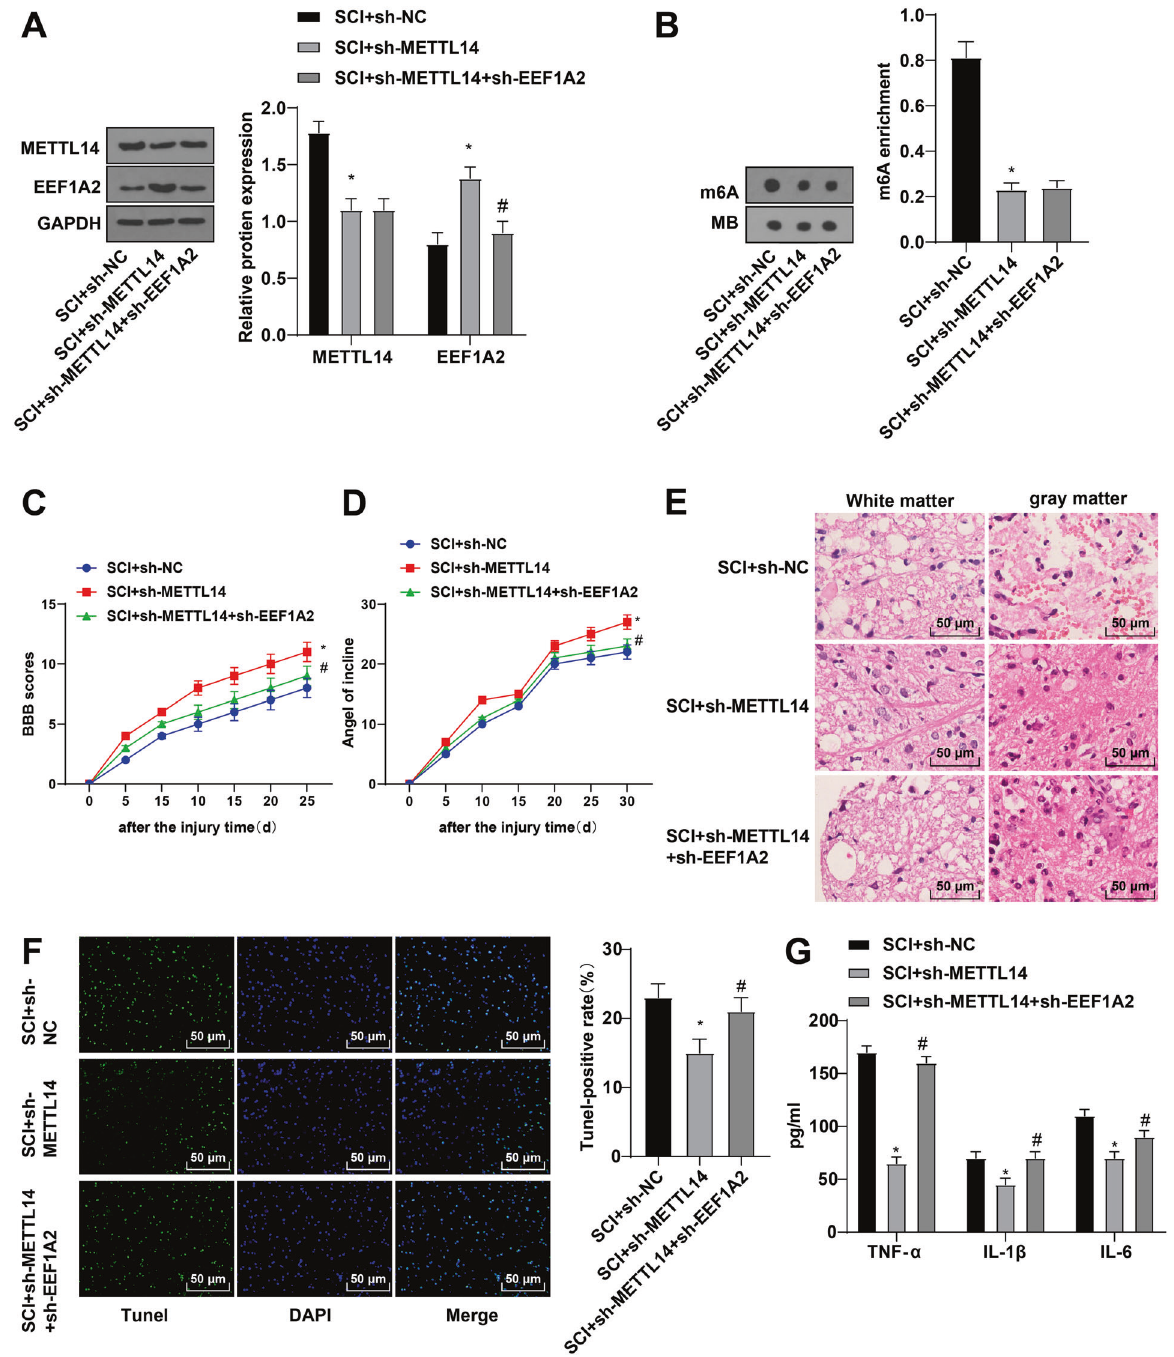
Fig. 6 Mettl14 modulated SCI by mediating EEF1A2 expression. A expressions of Mettl14, EEF1A2 proteins in spinal cord tissues detected by Western blot; ( B ) total m6A level detected by Dot blot assay; ( C ) locomotor ability detected by BBB locomotor rating scale; ( D ) neuronal function detected by inclined plane test; ( E ) pathological conditions of spinal cord assessed by HE staining; ( F ) apoptosis of spinal cord tissues detected by TUNEL staining; ( G ) expressions of TNF- α , IL-1 β and IL-6 detected by ELISA. Data were expressed as mean ± SD and analyzed using independent t test, N = 5. * vs SCI + sh-NC group, p < 0.05; # vs SCI + sh-Mettl14 + sh-EEF1A2 group, p < 0.05.